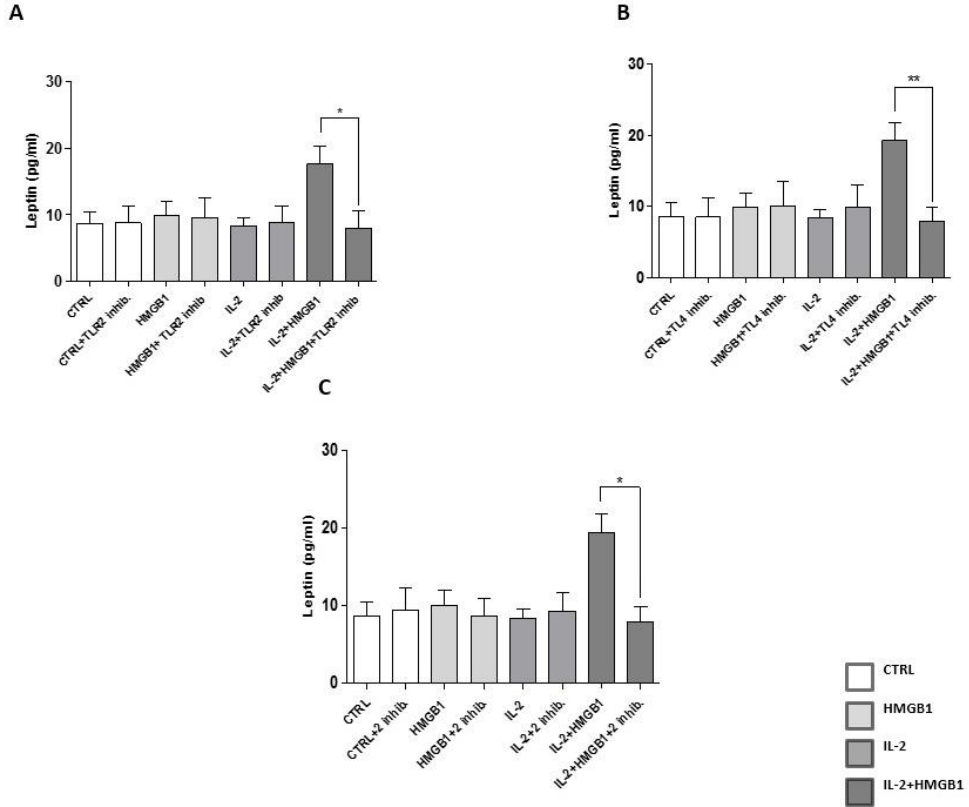
Figure 4. PBMCs leptin secretion were evaluated in the presence of Anti-hTLR2-IgA (TLR2 inhibitor) and/or TAK242 (TLR4 inhibitor) for 24 h; at the end of the treatment, PBMCs were incubated with IL-2 and/or HMGB1. Treatment with anti-hTLR2-IgA ( A ) and TAK242 ( B ) or combined treatment ( C ) significantly blunted leptin secretion in response to HMGB1 and IL-2 co-treatment. PBMCs were obtained from three healthy donors and data are expressed as mean ± SEM and were analyzed with Wilcoxon – Mann – Whitney U Test (* p < 0.05, ** p < 0.005). CTRL: control; TLR2: Toll Like Receptor 2; HMGB1: High Mobility Group Box1; IL-2: Interlukin-2; TL4: Toll Like Receptor 4